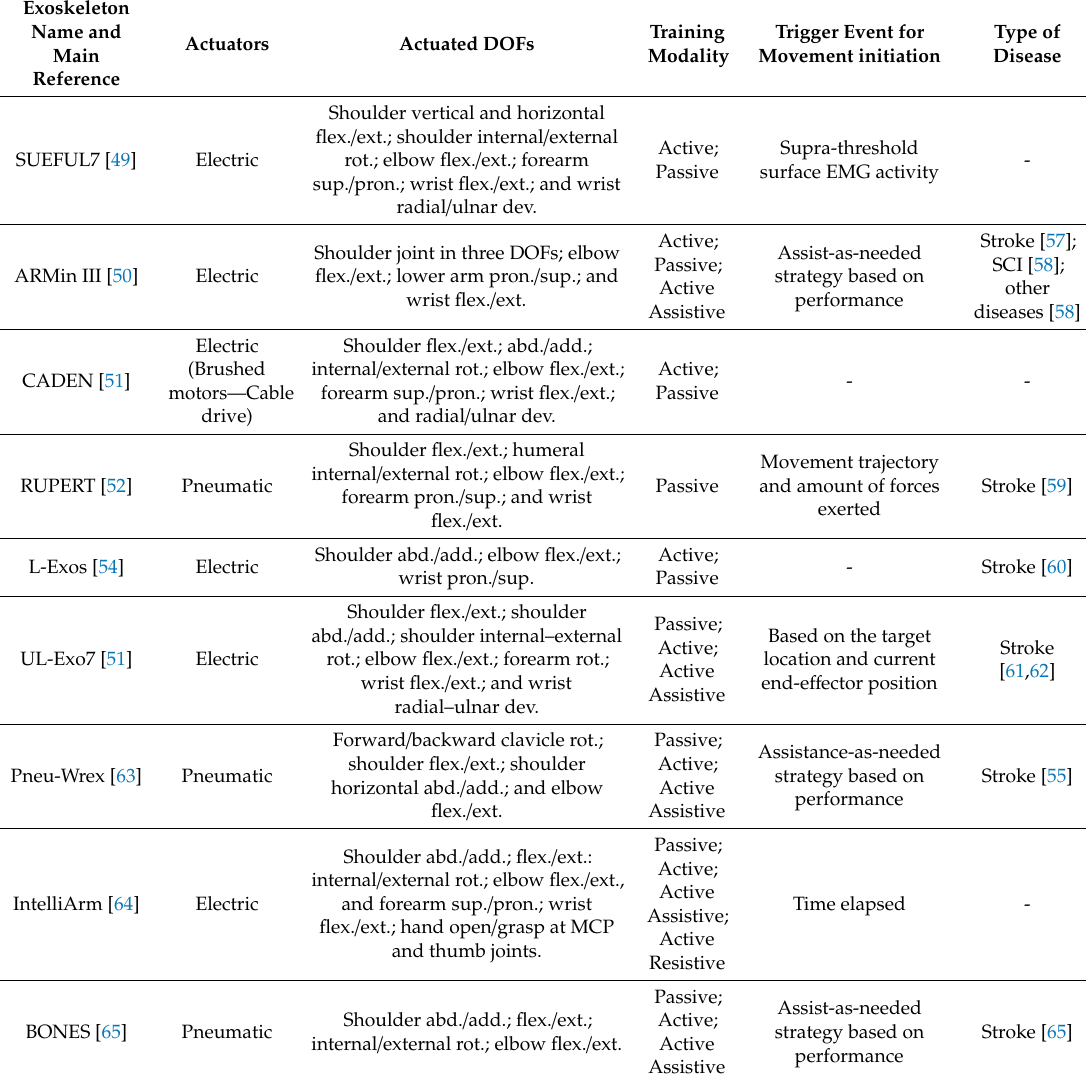
Table 2. Main features of the most common upper limbs